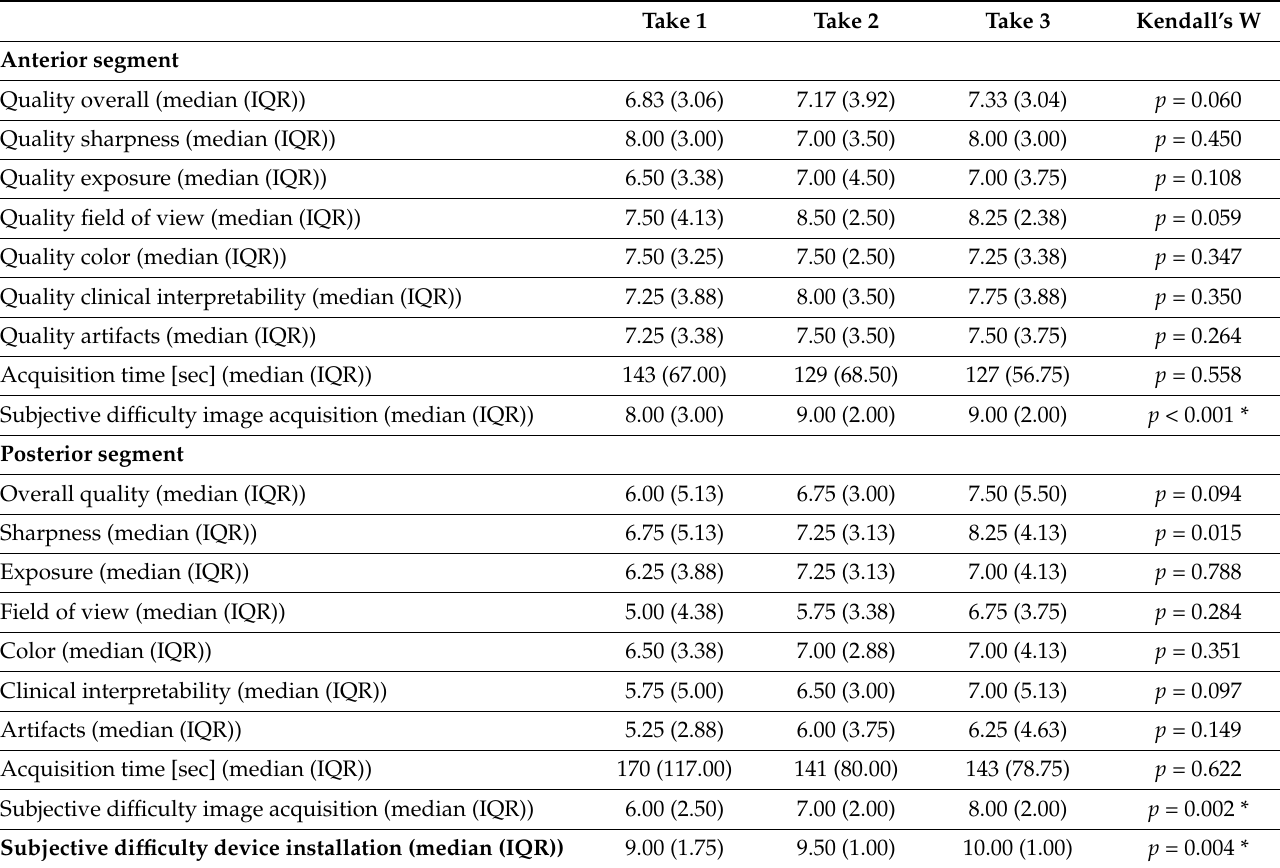
Table 3. Comparison of takes in the smartphone group.